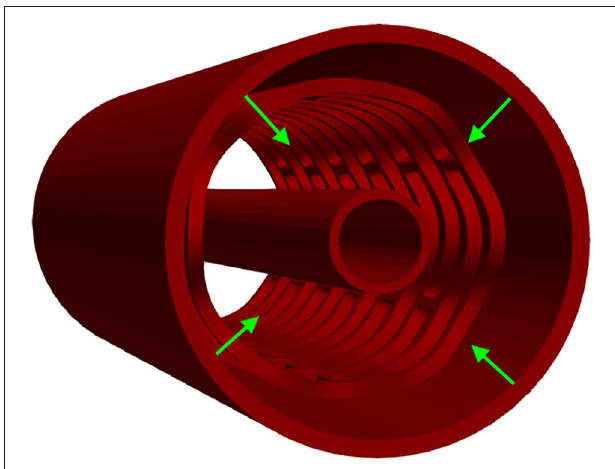
FIGURE 3 | Boundary conditions of a radial compression